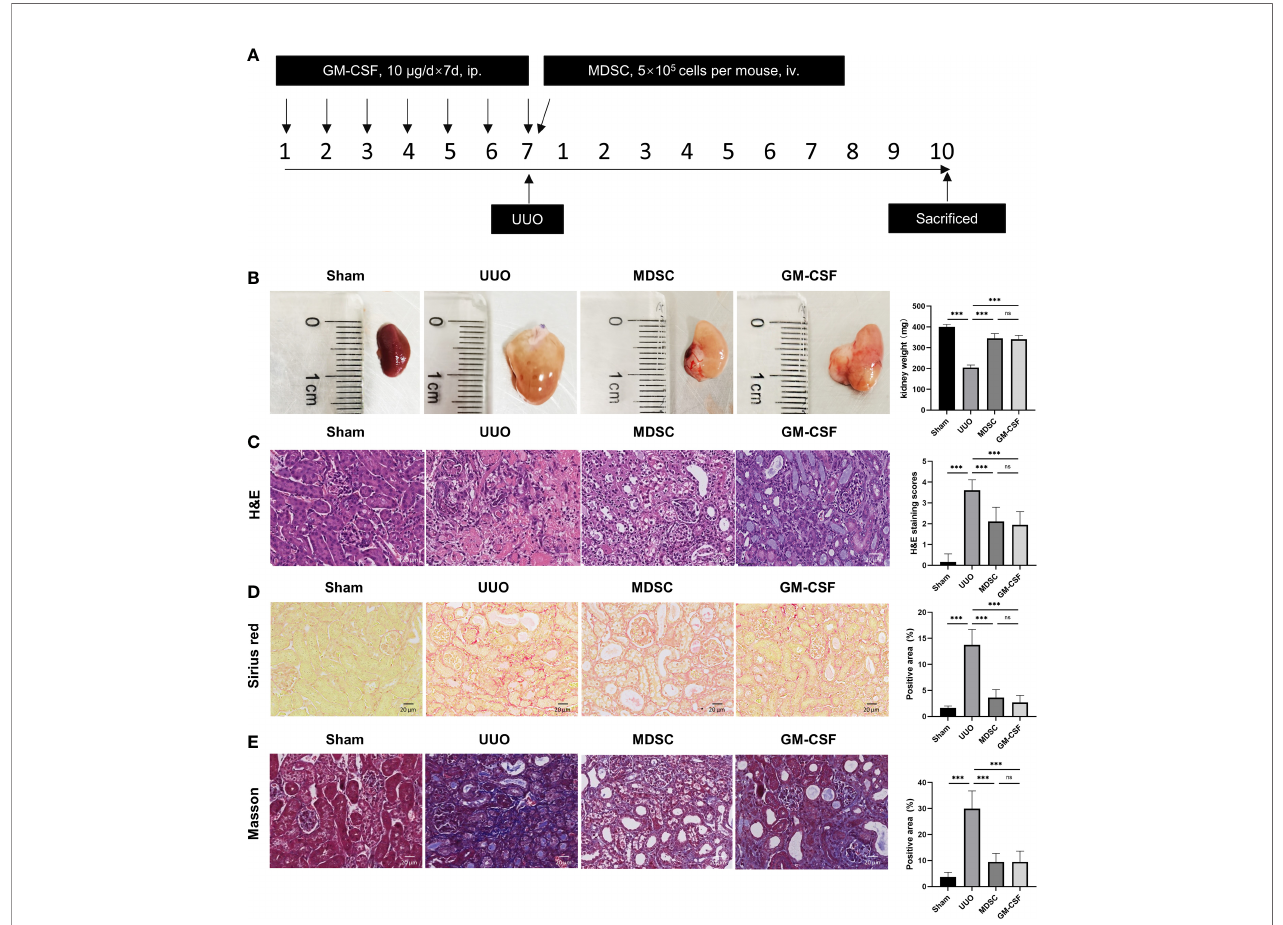
FIGURE 1 | BM-induced MDSCs and GM-CSF alleviate renal fi brosis induced by UUO. (A) Flow chart of the in vivo study. (B) Kidney size and weight at 10 days after UUO. (C) Representative micrographs of H&E staining of kidney sections (scale bar, 20 m m) and semiquantitative data of tubule injury score. (D) Representative micrographs of Sirius red staining and semiquantitative data of fi brosis area. (E) Representative micrographs of Masson staining and semiquantitative data of fi brosis area. Data are presented as the mean ± SD (n = 6). *** p < 0.001. ns^P >